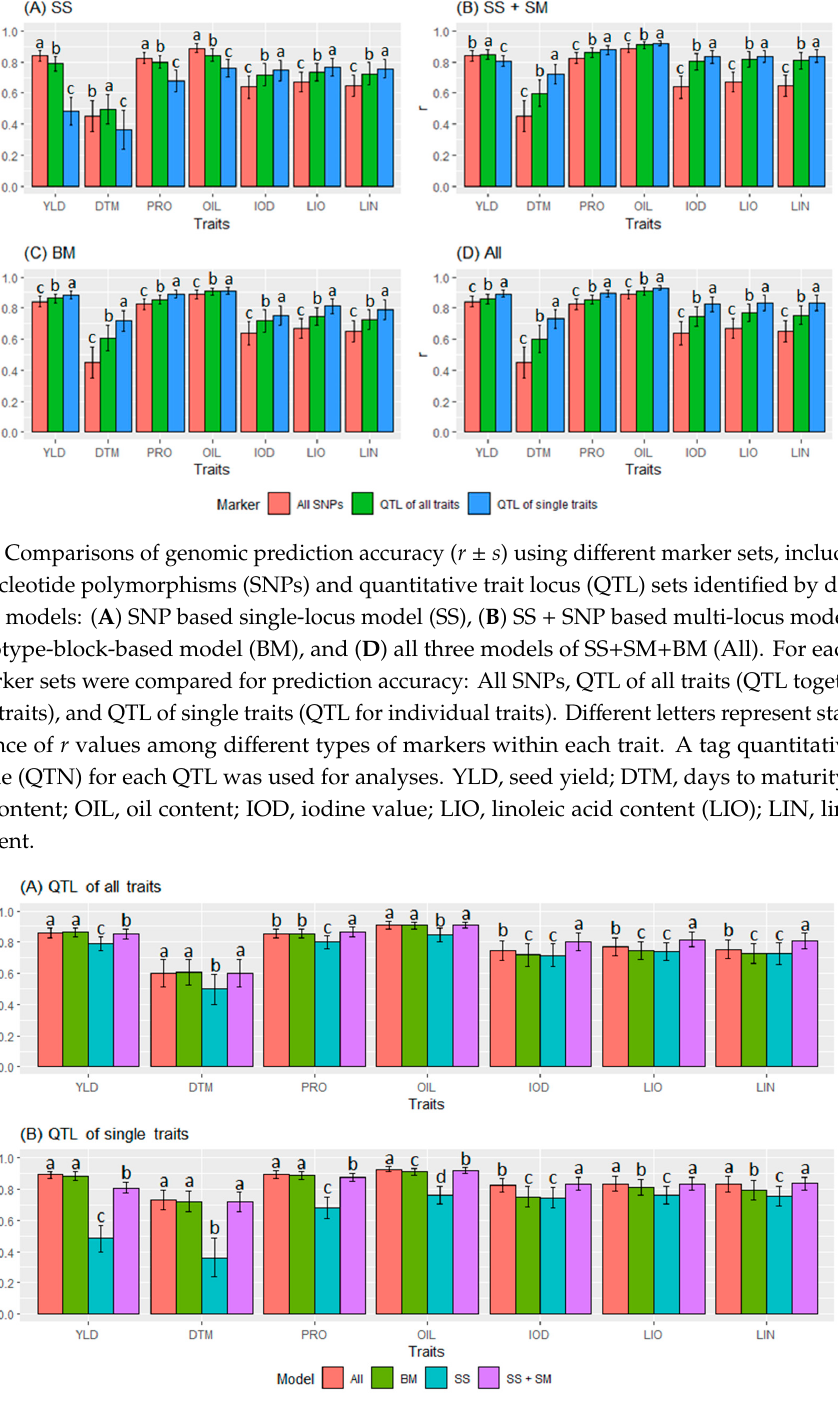
Figure 8. Comparisons of genomic prediction accuracy ( r ± s ) by different statistical models, including SNP-based single-locus model (SS), SS+SNP-based multi-locus model (SM), haplotype-block-based model (BM), and all three models of SS+SM+BM (All), which were used for quantitative trait locus (QTL) identification. ( A ) QTL of all traits were used for GS, and ( B ) QTL of single traits were used for GS. A tag quantitative trait nucleotide (QTN) for each QTL was used for analyses. For each trait, different letters represent statistical significance of r values among different GWAS models. YLD, seed yield; DTM, days to maturity; PRO, protein content; OIL, oil content; IOD, iodine value; LIO, linoleic acid content (LIO); LIN, linolenic acid content; SNP, single nucleotide polymorphism.